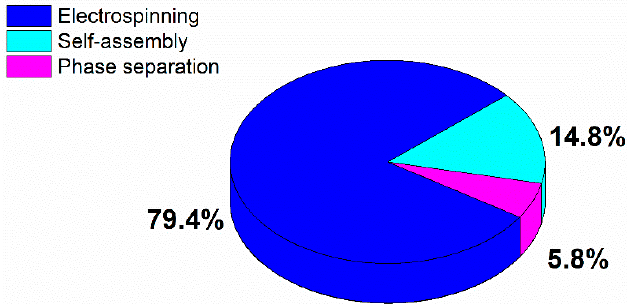
Figure 2. Distribution of publications published worldwide in the period 1994–2019 according to the most common used nanofibrous tissue engineering (TE) scaffold fabrication technique.